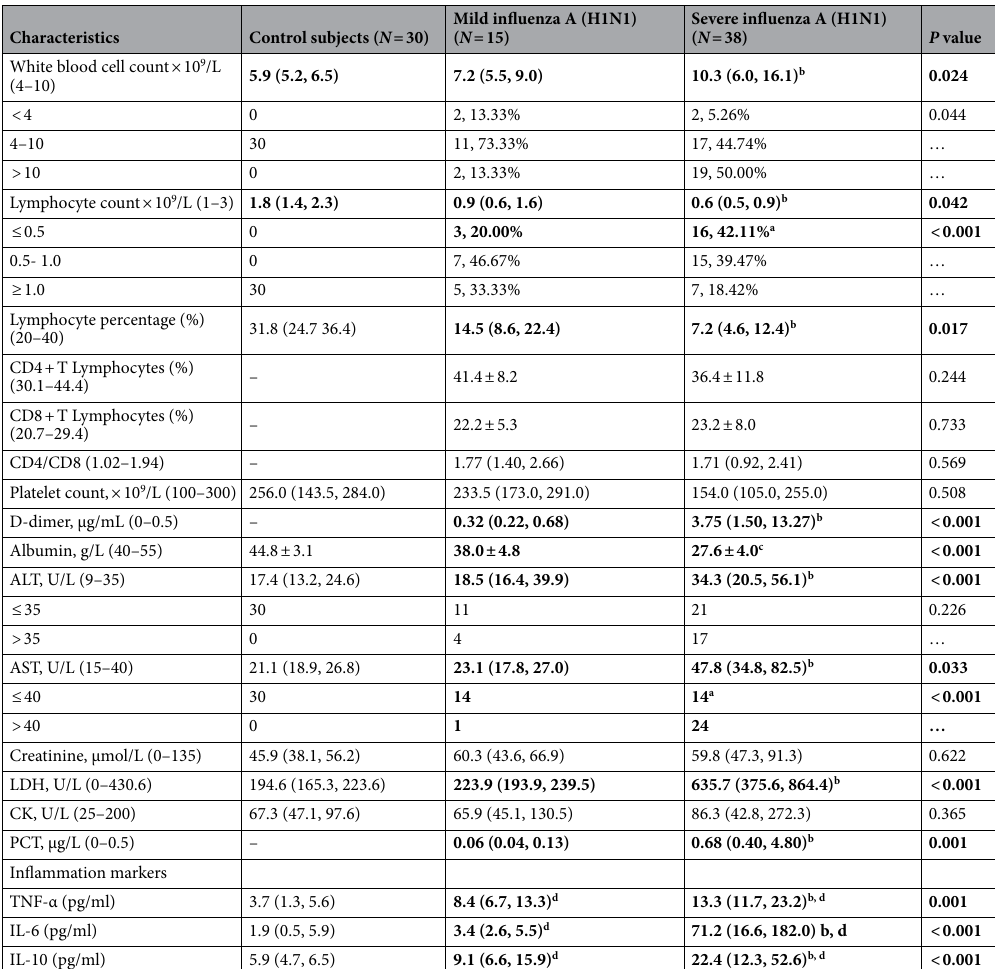
Table 2. Laboratory records and inflammation markers of patients infected with Influenza A (H1N1) on admission. Data are expressed as median (inter-quartile range), mean ± SD, or number (%). Abbreviations: ALT, Alanine aminotransferase; AST, Aspartate aminotransferase; LDH, Lactate dehydrogenase; CK, Creatine kinase; PCT, Procalcitonin; TNF, tumor necrosis factor; IL-6, interleukin-6; IL-10, interleukin-10. a , vs. Mild group, χ 2 tests; b , vs. Mild group, Mann – Whitney U test; c , unpaired Student t test. d, vs. Control group, Kruskal – Wallis test. –, This data were not collected